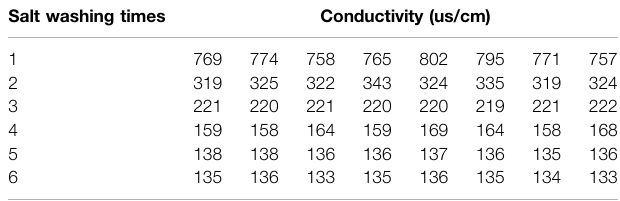
TABLE 3 | Conductivity test results of the original loess. Salt washing times